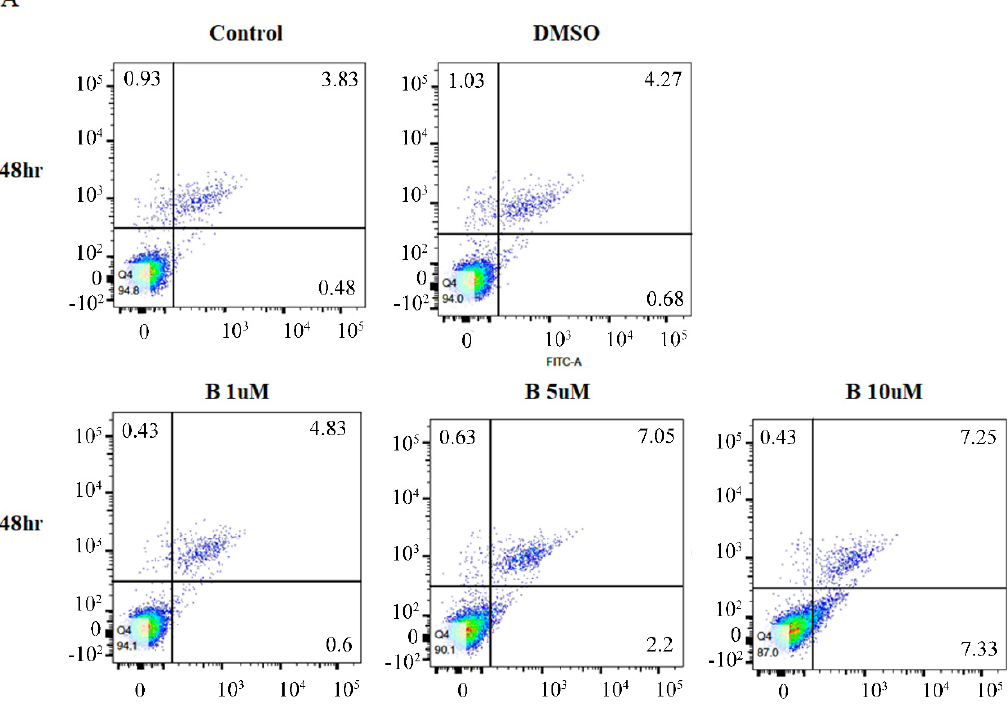
Figure 3. Bazedoxifene induces apoptosis in cervical cancer cells. ( A ) Apoptotic effects were detected using Annexin V- FITC/PI staining by flow cytometry in SiHa cervical cancer cells after 48 h. ( B ) Statistical analysis of the percentage of cell apoptosis. Bars indicate mean ± standard deviation of three independent experiments performed in triplicate (**, p < 0.01; ***, p < 0.001 vs. control). B: Bazedoxifene.